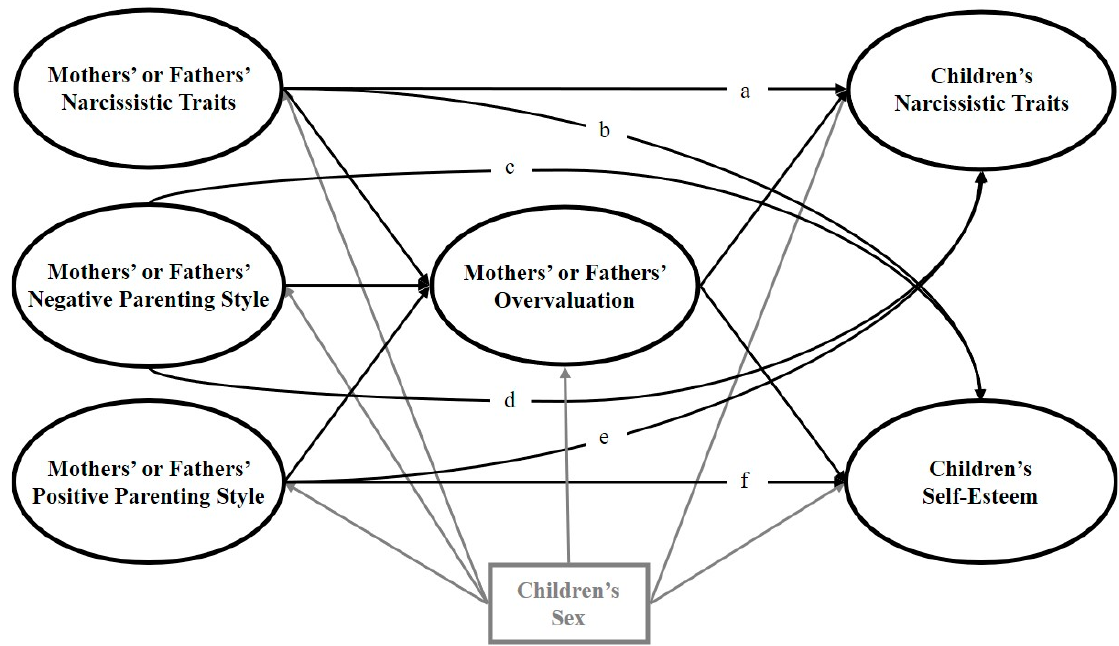
Figure 2. Theoretical partial mediation models of the relations of parental narcissism, positive parenting, and negative parenting with children’s narcissism and self-esteem including (1) the six direct paths a, b, c, d, e, or f; and (2) the indirect paths via parental overvaluation. The key study variables and their related paths are presented in black. As the control variable, sex and its related paths are presented in gray.